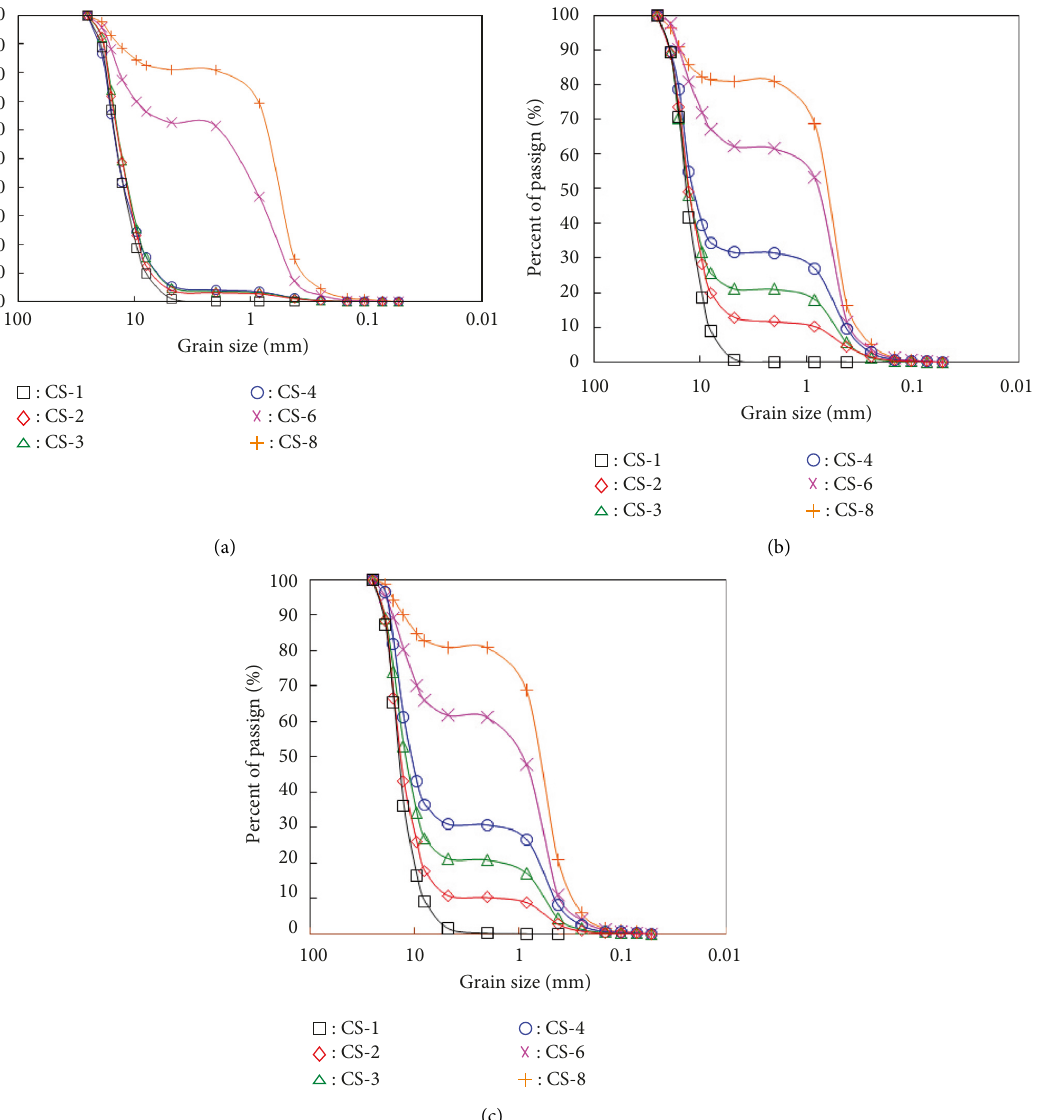
Figure 6: Sample grain size distributions based on compaction condition: (a) loose, (b) normal, and (c)